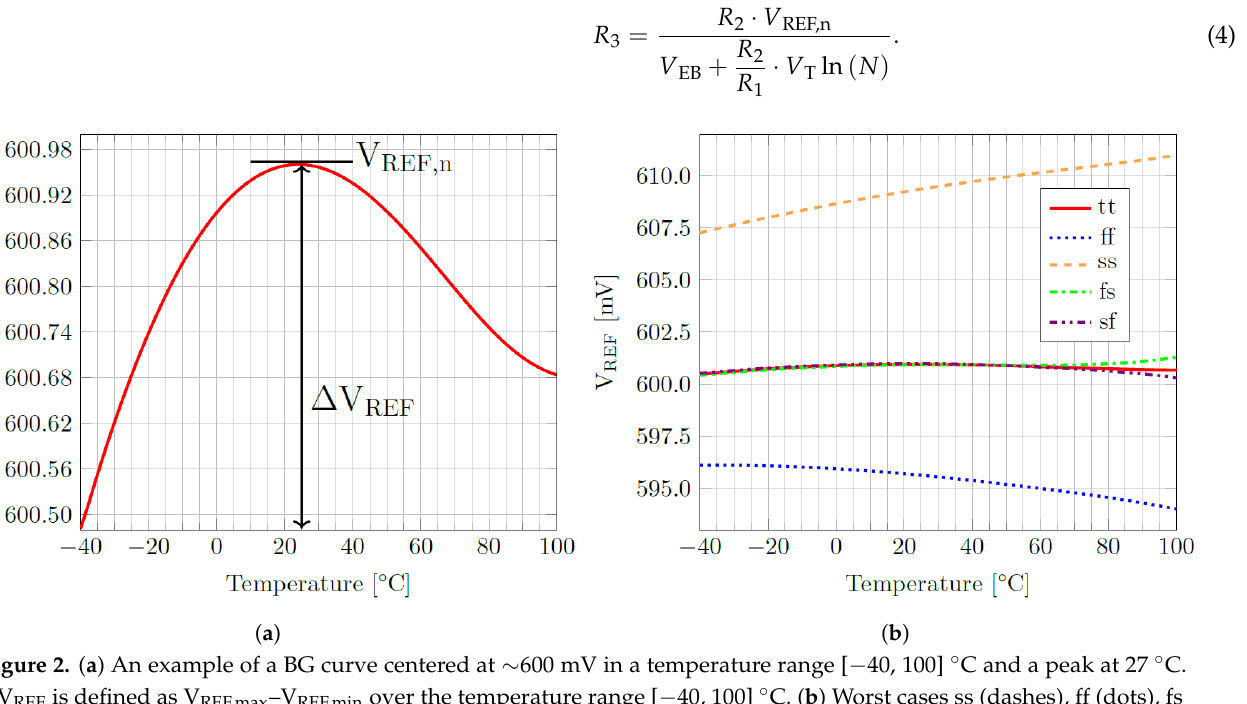
Figure 2. ( a ) An example of a BG curve centered at ∼ 600 mV in a temperature range [ − 40, 100] ◦ C and a peak at 27 ◦ C. ∆ V REF is defined as V REF,max –V REF,min over the temperature range [ (dash, dot) and sf (dash, dot, dot) are superimposed on the nominal case tt